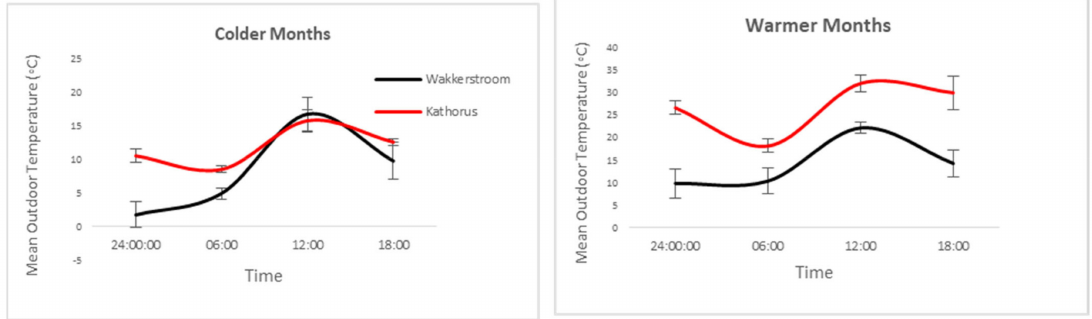
Figure 10. Mean ambient temperature readings (n = 4) at selected times throughout the day during colder (left) and warmer months (right) throughout the day in Kathorus and Wakkerstroom, the error bars indicate daily mean temperature variance (throughout the sampled period). Kathorus had ambient temperatures which were higher than Wakkerstroom, this is especially evident during the warmer months.